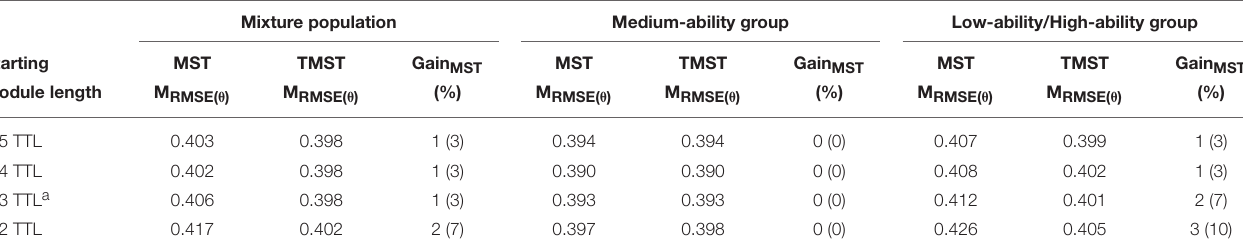
TABLE 6 | Mean RMSE( ˆ θ ) and gain of TMST over MST design for MST and TMST designs with different starting module lengths per ability group. Mixture